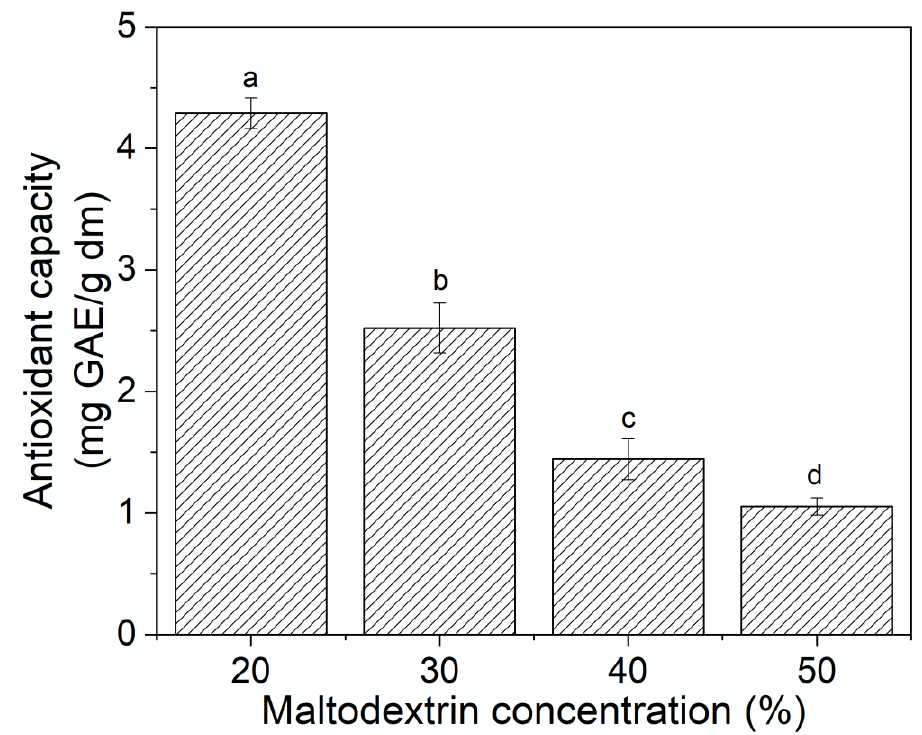
Figure 6. Antioxidant activity (DPPH • scavenging capacity) of the freeze-dried powders obtained using di ff erent maltodextrin (MD) concentrations. Values with di ff erent superscript letters are significantly di ff erent ( p < 0.05).